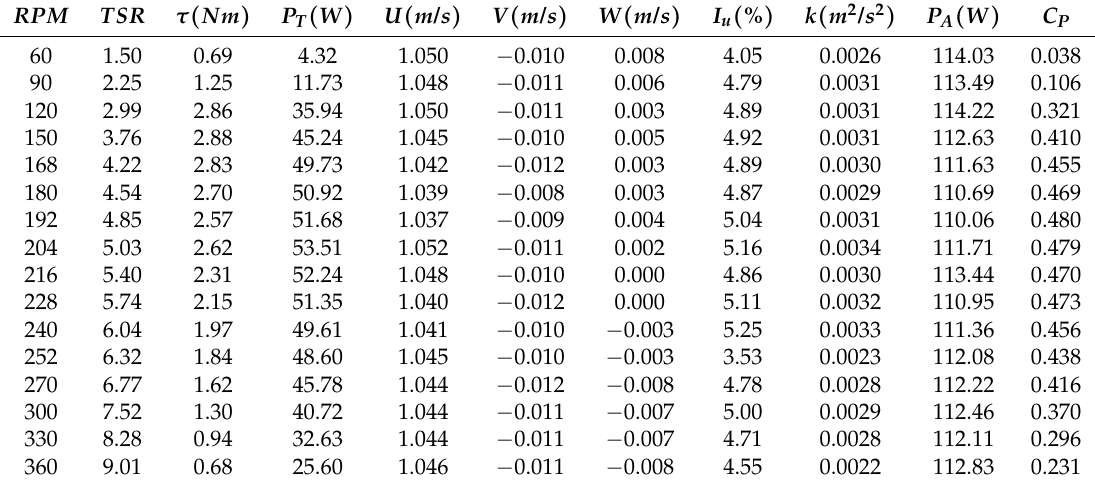
Table A2. Performance testing conditions and summary—RM1 right rotor, y / d T =